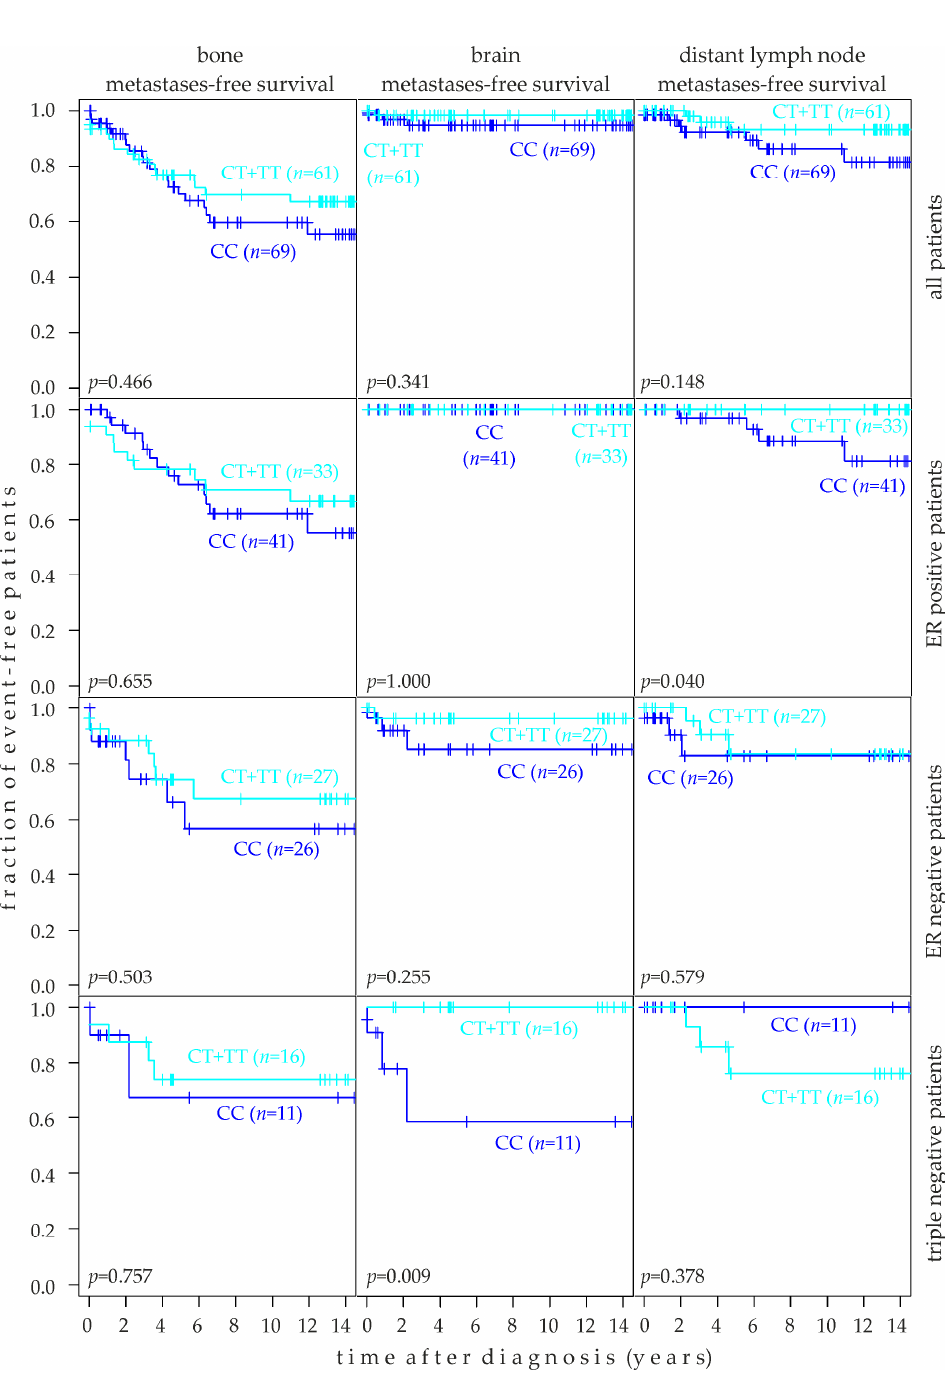
Figure 6. Association of rs10069690 genotypes with the target tissue-specific metastasis-free survival of human breast cancer patients. Patients with CT and TT genotypes were combined into one group and compared to CC patients. Kaplan-Meier analyses of the bone metastasis-free survival, brain metastasis-free survival, and survival free of metastasis to distant lymph nodes in unselected patients (top row, n = 130), estrogen receptor (ER) positive patients (second row; n = 74), ER-negative patients (third row; n = 53), and triple-negative patients (bottom row; n = 27) are shown. Numbers ( n ) of patients in each group and p -values ( p ) are indicated.